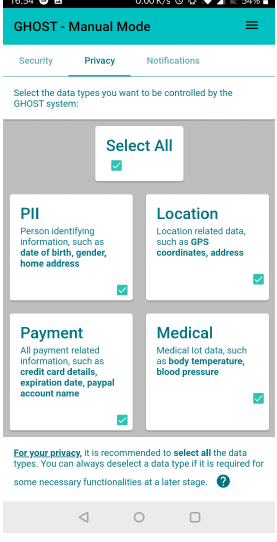
Figure 9. Privacy preferences.